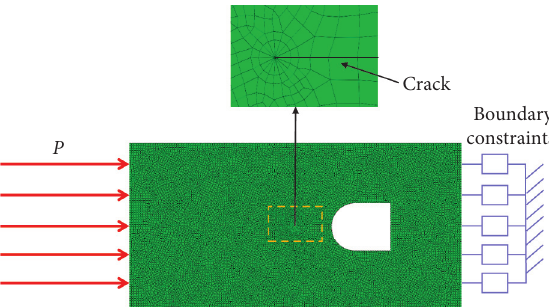
Figure 17: Typical mesh of specimen in ABAQUS.